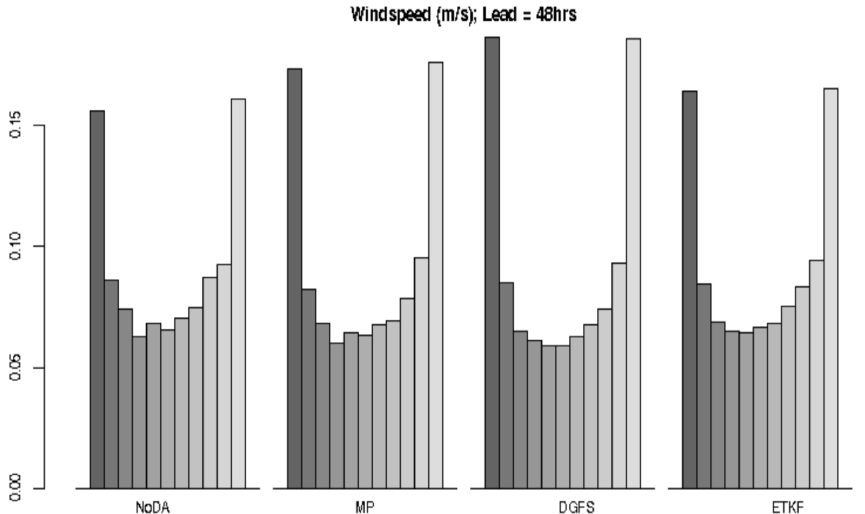
Figure 2. Rank histogram of 48 h ensemble wind speed forecasts from multi-physics WRF-based ensemble systems using GEFS ICs with no data assimilation (NoDA), model parameter perturbations (MP), and Ensemble Transform Kalman Filter (ETKF) data assimilation. DGFS used GEFS ICs but with the same WRF configuration for all members, serving as a baseline for